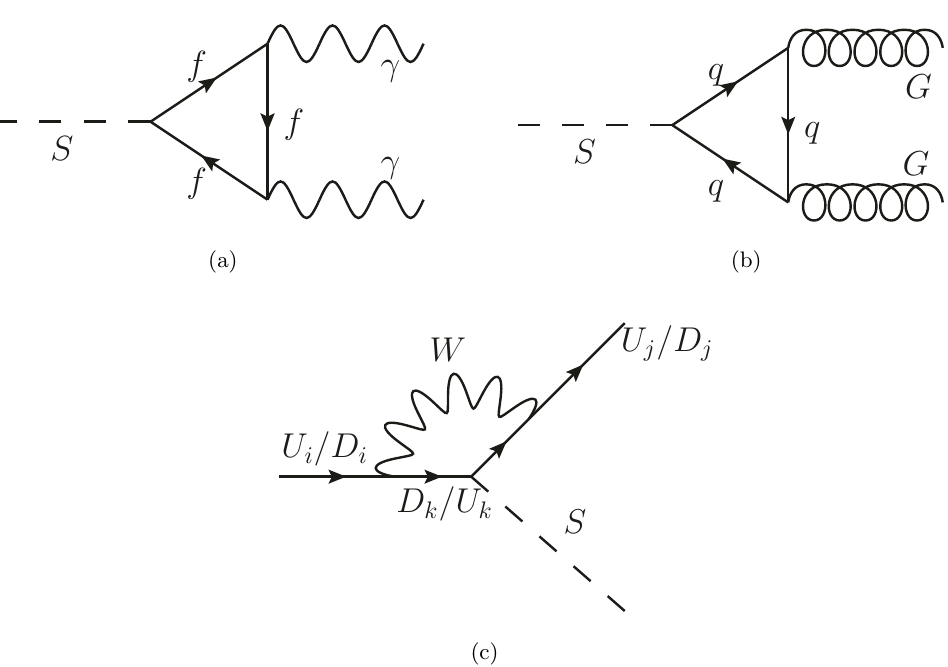
Figure 1 . Examples of e(cid:11)ective interactions of the scalar with photons (a), gluons (b), and (cid:13)avor changing quark operators (c). (See appendix A for details.)